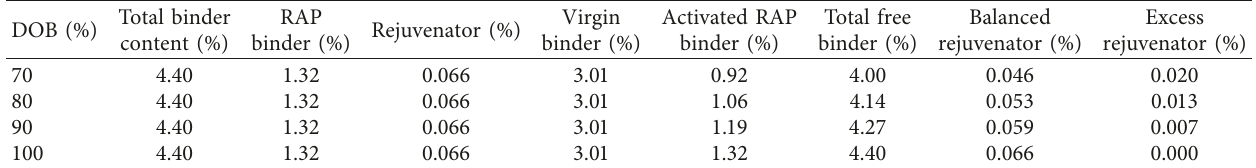
Table 14: Composition of binder in HMRAM with 30% RAP